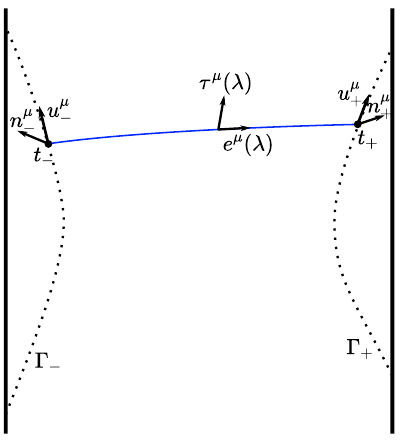
, shown in blue, at finite (cid:15) . The length Figure 3 . The geometry of the two-sided geodesic y µ t − t + L ( t − , t + ) of this geodesic and the relative boosts η ± ( t − , t + ) between its rest frame and those of the left and right boundaries Γ define three diffeomorphism-invariant ±